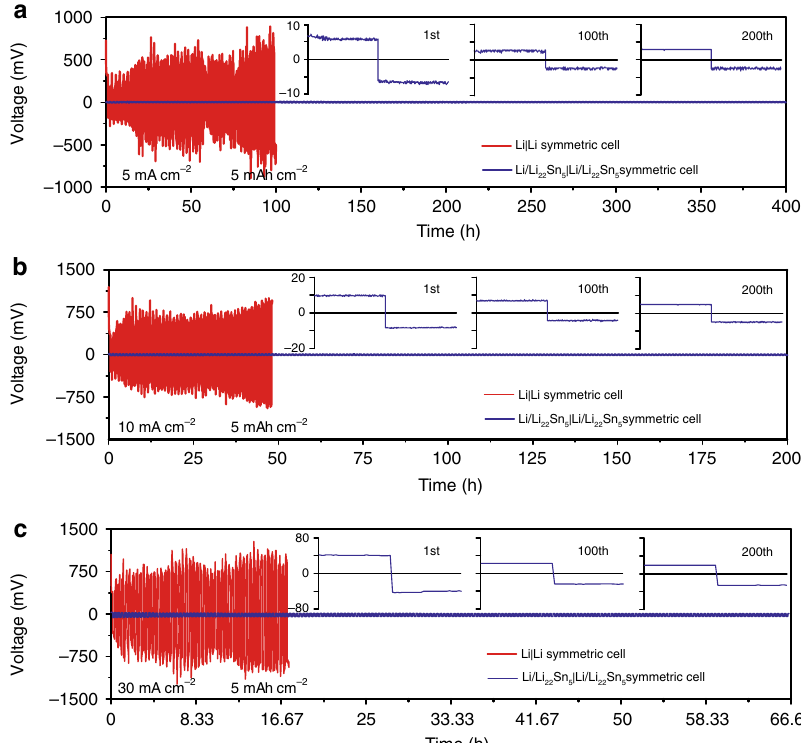
Fig. 2 Galvanostatic lithium plating/stripping cycling and voltage pro fi les of the Li/Li 22 Sn 5 | Li/Li 22 Sn 5 and Li|Li symmetric cells. a – c Lithium stripping/ plating cycling of symmetric cells at 5 mA cm − 2 ( a ), 10 mA cm − 2 ( b ) and 30 mA cm − 2 ( c ) with areal capacity fi xed at 5 mAh cm − 2 . The insets in ( a – c ) are the high-resolution voltage pro fi les of the Li/Li 22 Sn 5 |Li/Li 22 Sn 5 symmetric cells at the speci fi c